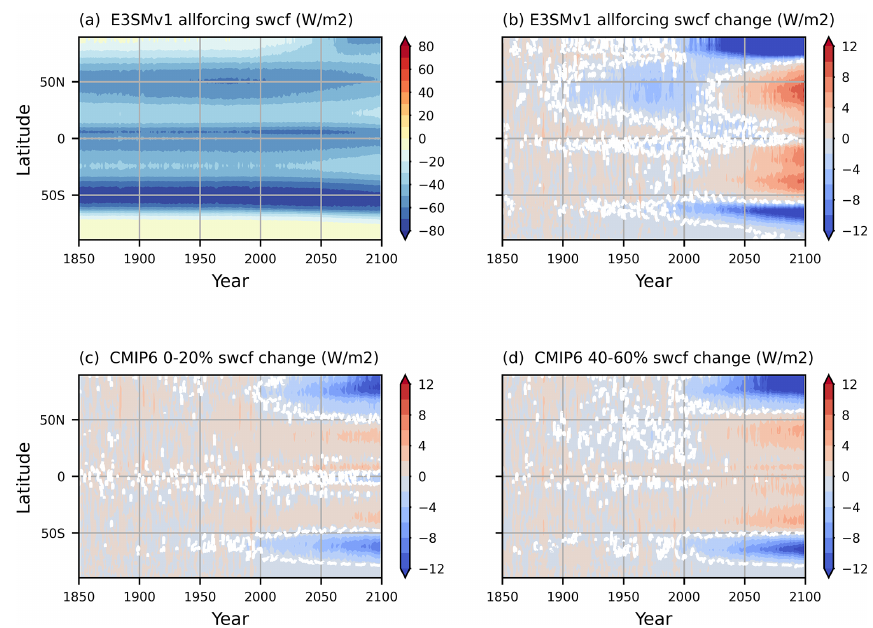
Figure 6. Time evolution of zonal mean (a) SWCRE for E3SMv1.0. Time evolution of the local changes in zonal mean SWCRE with respect to 1850–1869 from the historical simulations and SSP5-8.5 future climate simulations (b) E3SMv1.0, (c) CMIP6 models within the 0–20th percentiles, and (d) the 40–60th